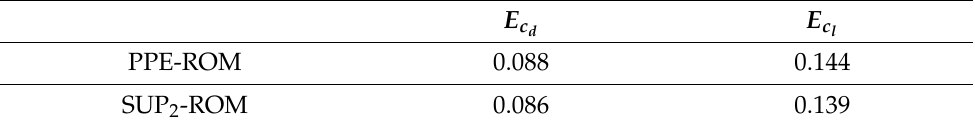
Table 3. Relative errors (71) for lift and drag coefficients for PPE-ROM and SUP 2